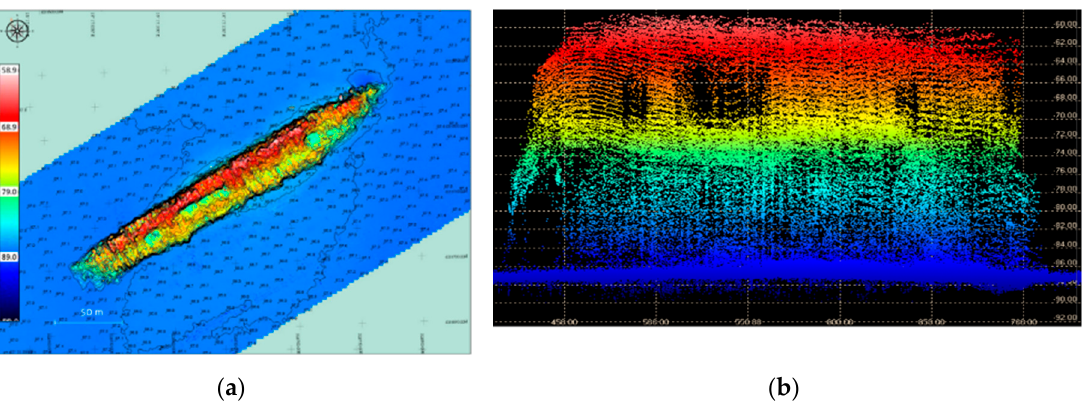
Figure 12. Distribution of depth values in the area of the Graf Zeppelin aircraft carrier wreck ( a ) and presentation of multibeam echo sounder (MBES) data along the shipwreck ( b ).